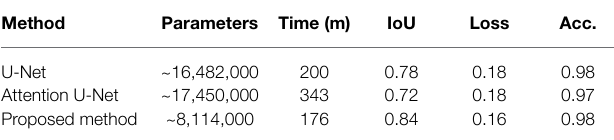
TABLE 2 | Comparison of the proposed convolutional neural network (CNN) relative to two other common CNN architectures.